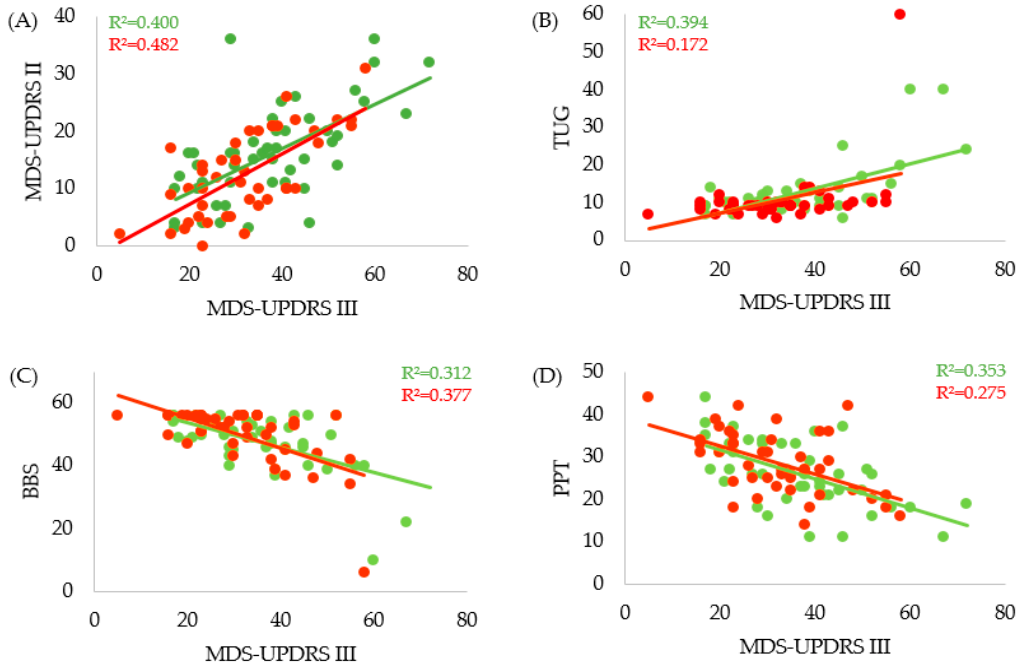
Figure 3. Significant correlations between MDS-UPDRS Part III and distinct motor parameters at BL (green) and DC (red). Trend lines indicate a linear relation. Significance level at 5%. ( A ) Correlation of MDS-UPDRS II and MDS-UPDRS III. ( B ) Correlation of TUG and MDS-UPDR III. ( C ) Correlation of BBS and MDS-UPDRS III. ( D ) Correlation of PPT and MDS-UPDRS III. Parameters are scaled in absolute counts of each scale, except for TUG which is measured in seconds. MDS-UPDRS: Movement Disorders Society Unified Parkinson’s disease Rating Scale Parts II and III, TUG: Timed Up and Go, BBS: Berg Balance Scale, PPT: Purdue Pegboard Test.